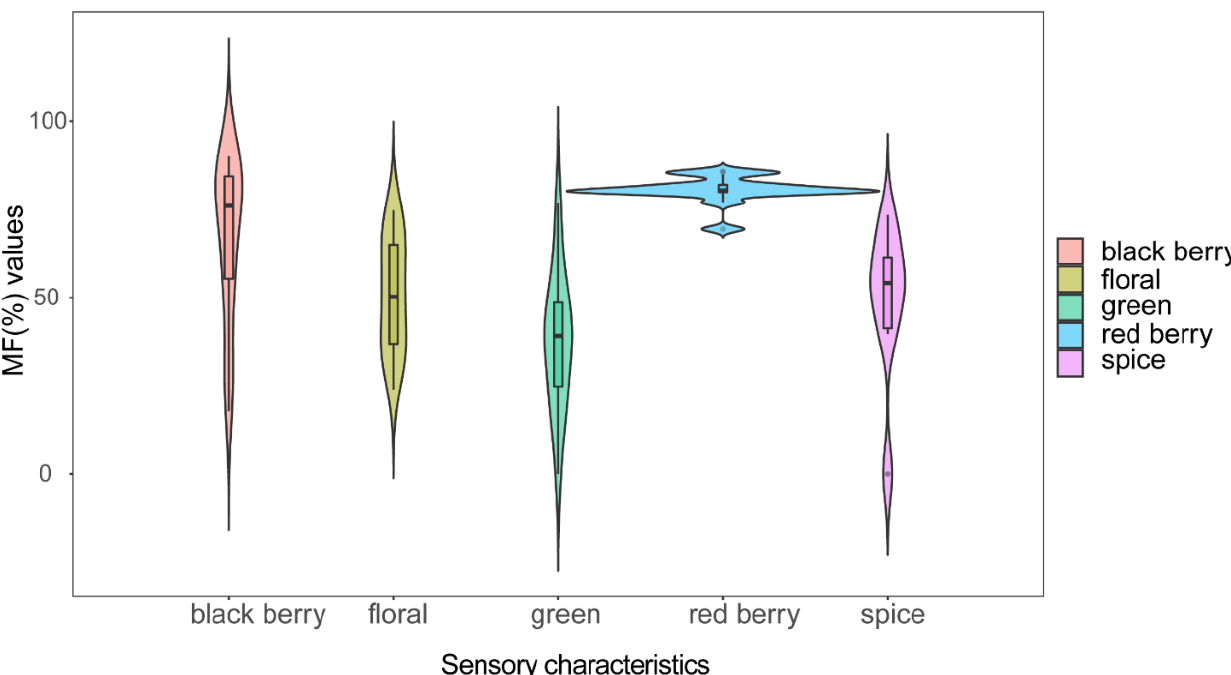
Figure 3. Violin plot showing the MF (%) values of sensory characteristics of the wine samples among various varieties and clones.